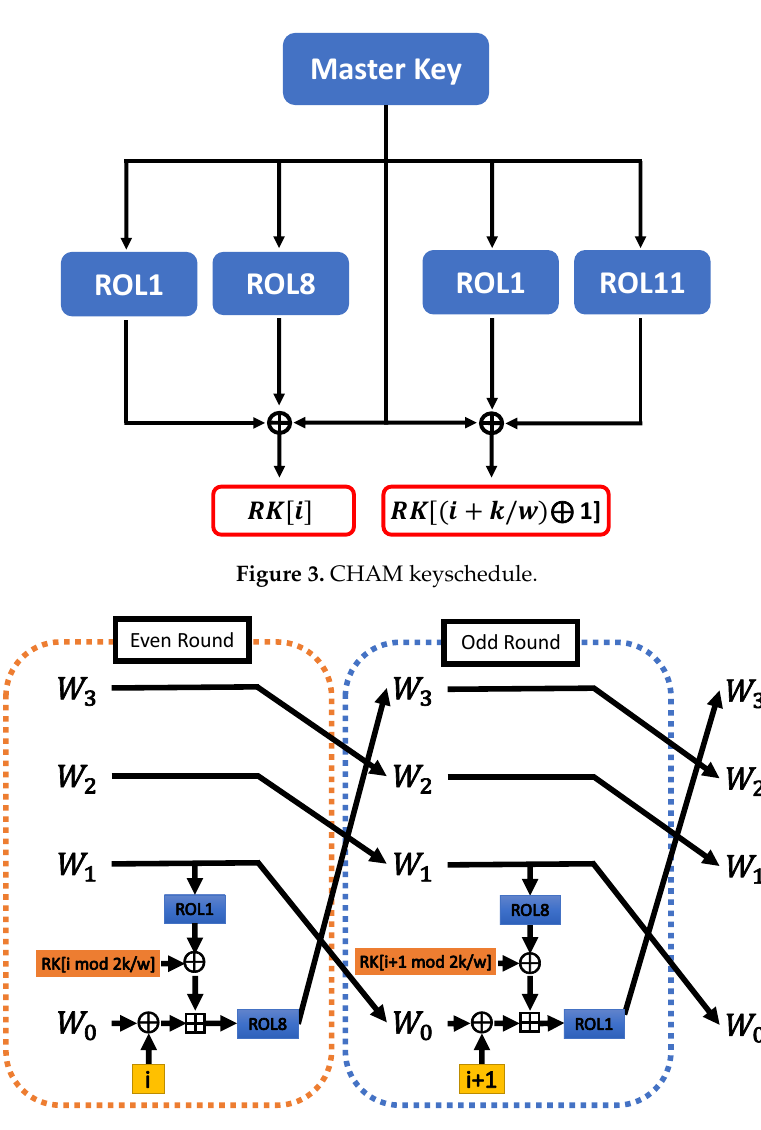
Figure 4. CHAM round